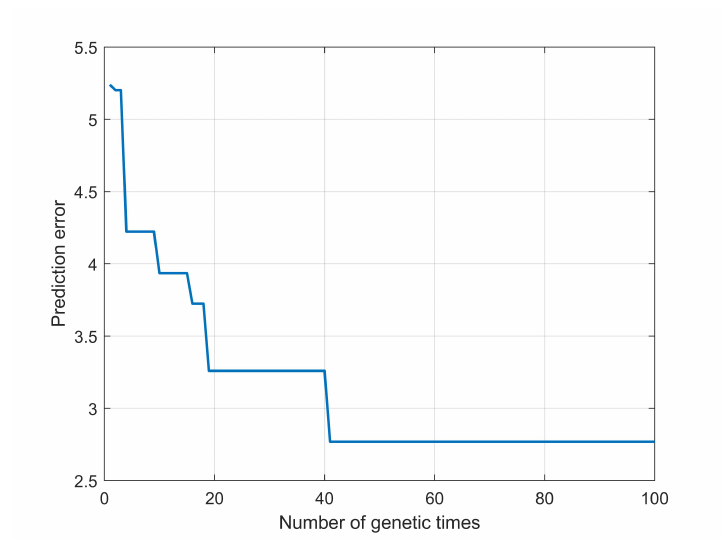
Figure 11. The change process of prediction errors of GA-ELMPS.